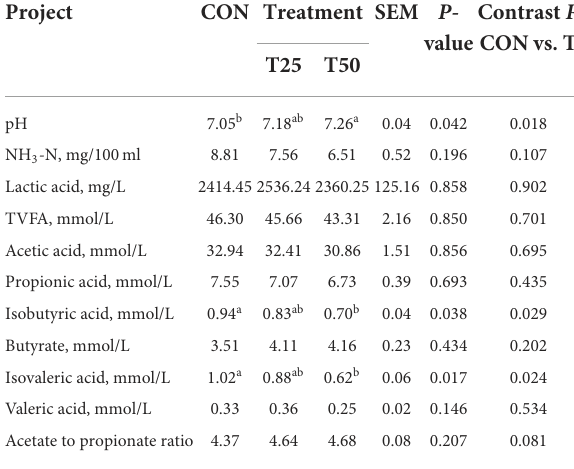
TABLE 8 Effects of FPR addition on rumen fermentation parameters.